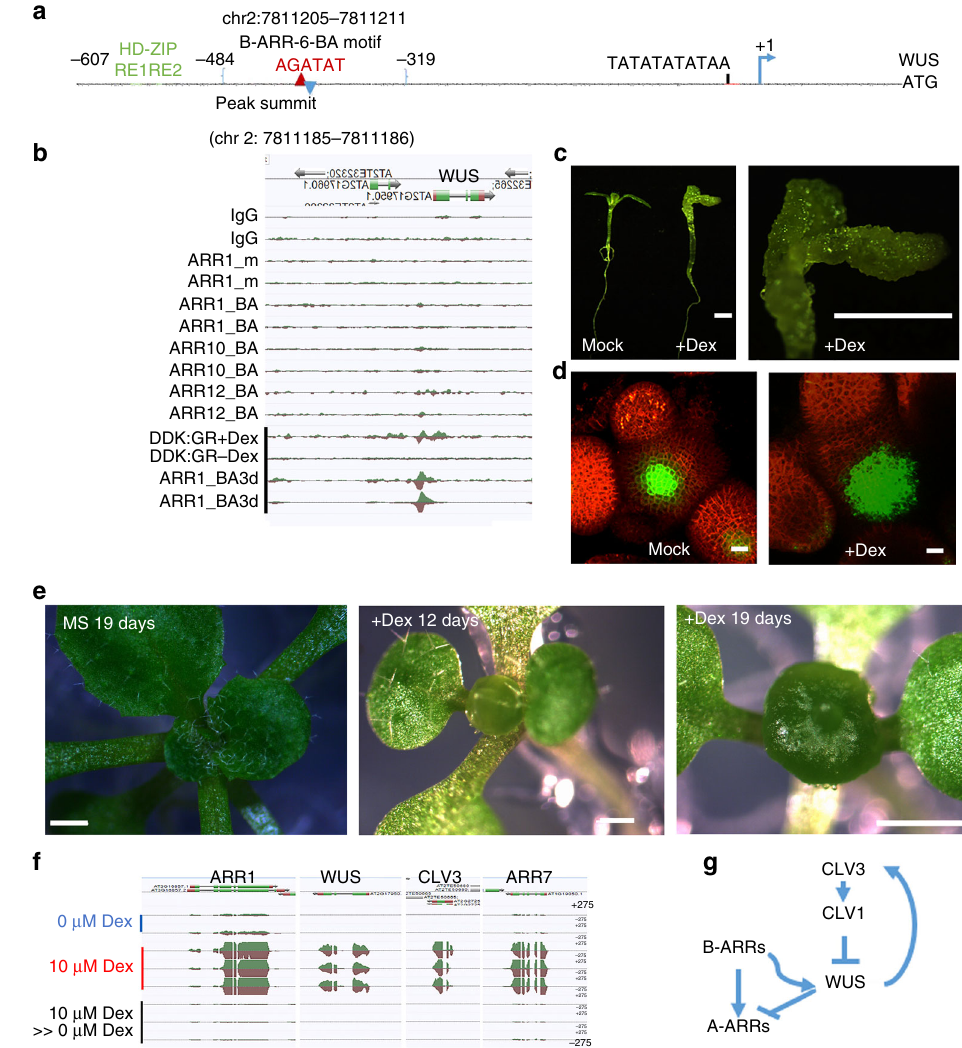
Fig. 6 Cytokinin dependent B-ARRs targeting of the WUS promoter. a The location of the AGATAT B-ARR-6-BA motif relative to the WUS gene ’ s TSS. The number (7811185) of the peak summit is the genomic position on the second chromosome. b An AnnoJ snapshot showing B-ARRs binding to WUS promoter requires a high concentration of cytokinin. Y -axis heights are scaled to same value. Black bar indicates plants grown on plates with 10 µ M 6-BA for 3 days (BA3d) or ARR1 Δ DDK::GR plants treated with 10 µ M Dex. c , d Phenotypes of p35S::ARR1 Δ DDK::GR . c Phenotypes of 11 days old transgenic plants without Dex (Mock), with Dex ( + Dex), and at higher magni fi cation ( + Dex). Scale bar = 1 mm. d 3D-reconstructed views of shoot apical meristems (SAMs) showing pCLV3::mGFP5-ER (CZ/stem cell reporter; green) and 35S::YFP29-1 (plasma membrane-localized YFP marks the outlines of all cells, red). SAM of mock-treated plants 4 days after treatment (Mock) and SAM of Dex-treated plants 4 days after treatment ( + Dex). Scale bar = 10 µ M. e Enlarged shoot apical meristem ( “ ball ” of SAM)) by the inducible expression of the constitutive active form ARR1 ( ARR1 Δ DDK:GR ) in stem cell domain ( CLV3 domain). Scale bar = 1 mm. The transgenic plants without Dex induction as a control after growth on MS for 19 days (MS 19 days). “ Ball ” of SAM after growth on 10 µ M Dex plate for 12 days ( + Dex 12 days). “ Ball ” of SAM after growth on 10 µ M Dex plate for 19 days ( + Dex 19 days). f RNA-seq reads tracks of the “ ball ” of SAM system demonstrating the expression of ARR1, ARR7 , WUS , and CLV3 . Transgenic plants grown on MS for 19 days (0 µ M Dex), on 10 µ M Dex plate for 19 days (10 µ M Dex) and grown on 10 µ M Dex plate for 12 days then transferred to MS for 7 days (10 µ M Dex > 0 µ M Dex). All tracks have the same scaling of y -axes ( + 275/ − 275). g A sketch showing the interface between the cytokinin response and the CLV3-WUS